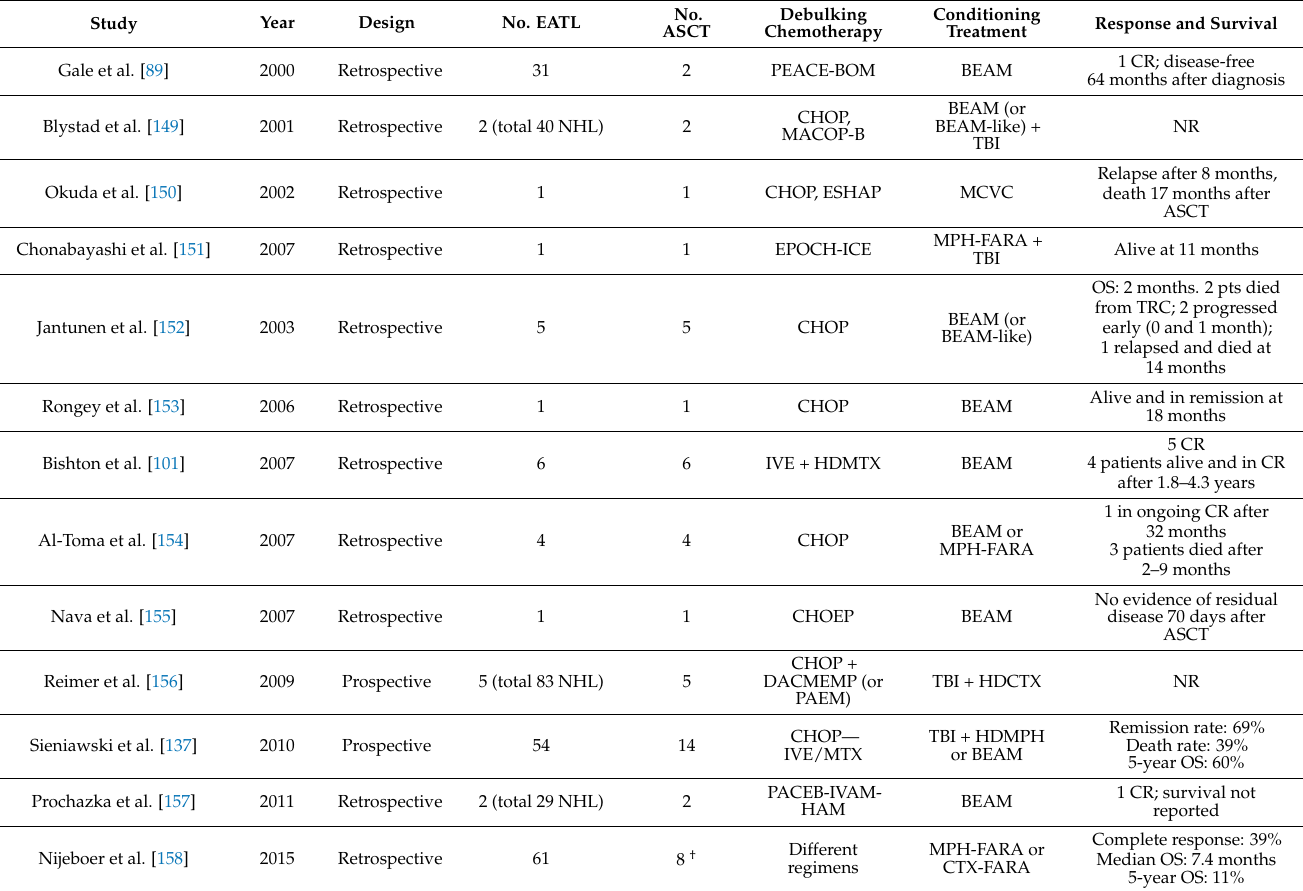
Table 2. Studies investigating treatment with high-dose chemotherapy followed by stem cell transplantation.